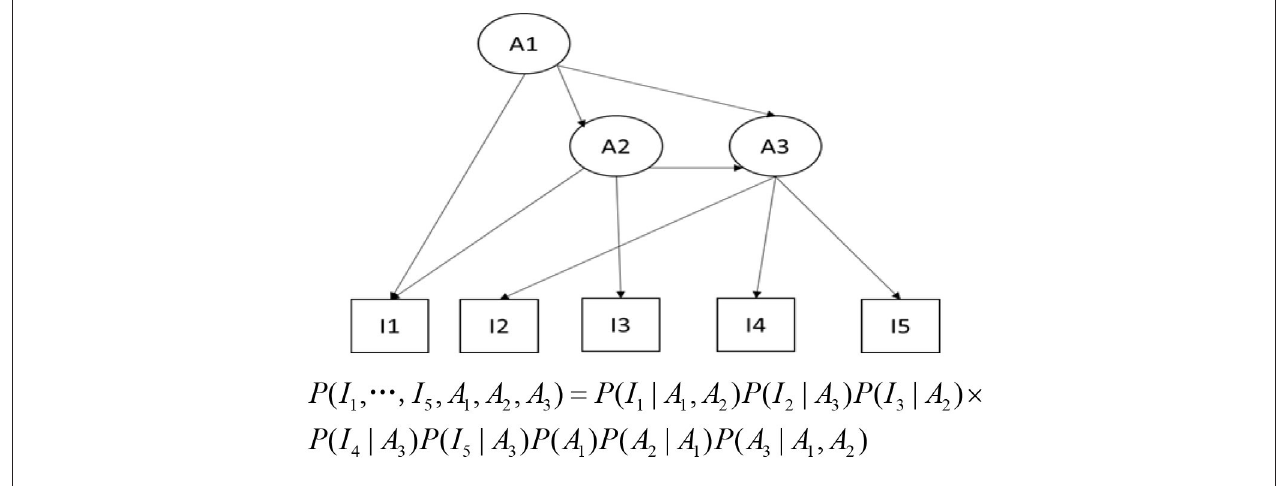
FIGURE 1 | A Bayesian network applied for cognitive diagnosis.